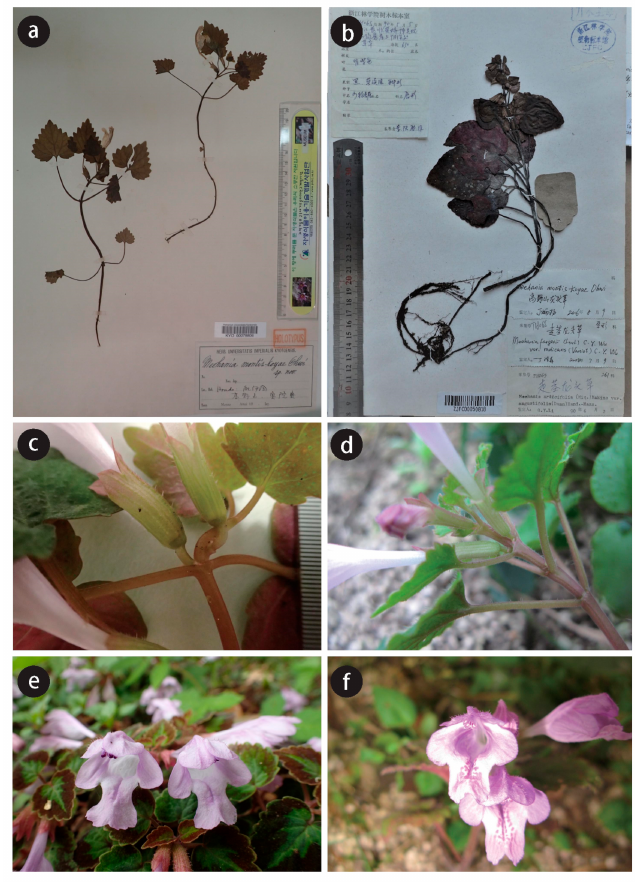
Figure 1. Chinese and Japanese M. montis-koyae . ( a ) Holotype of M. montis-koyae (KYO), collected from Mt. Koya, Wakayama Pref., Japan; ( b ) Specimen collected from Taishun, Zhejiang, China (ZJFC00050818); ( c , d ) close-up of stem: Japanese plant ( c ), Chinese plant ( d ); ( e , f ) flowers: Japanese ( e ), Chinese plant ( f